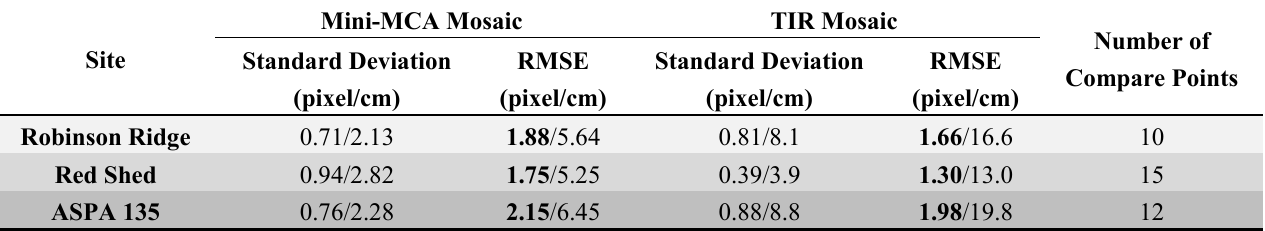
Table 3. Co-registration accuracy of mini-Multi Camera Array (mini-MCA) and Thermal Infrared (TIR) mosaics as compared to the visible